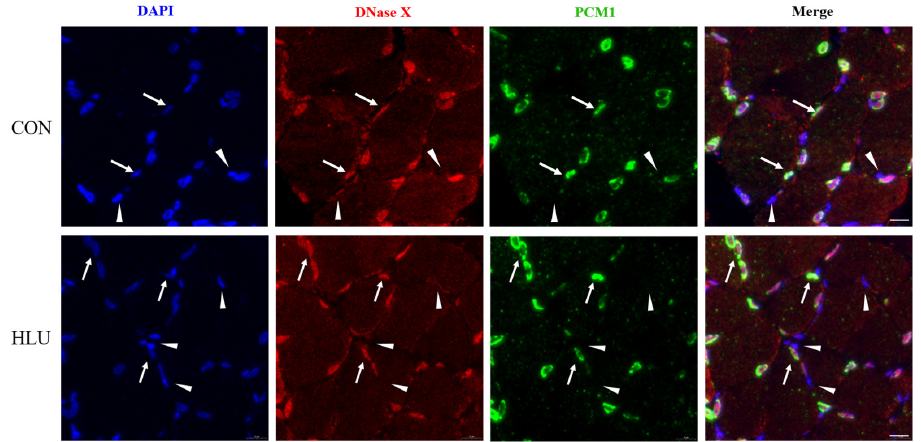
Figure 7. Co-localization of DNase X with PCM1. DNase X and pericentriolar material 1 (PCM1) immunofluorescence double staining on muscle slice in the CON and HLU groups. Nuclei were blue after DAPI staining. DNase X was red and PCM1 was green after immunofluorescence staining. DNase X co-localized with PCM1 was indicated by an arrow, and DNase X not co-localized with PCM1 was indicated by an arrowhead. Scale bar, 10